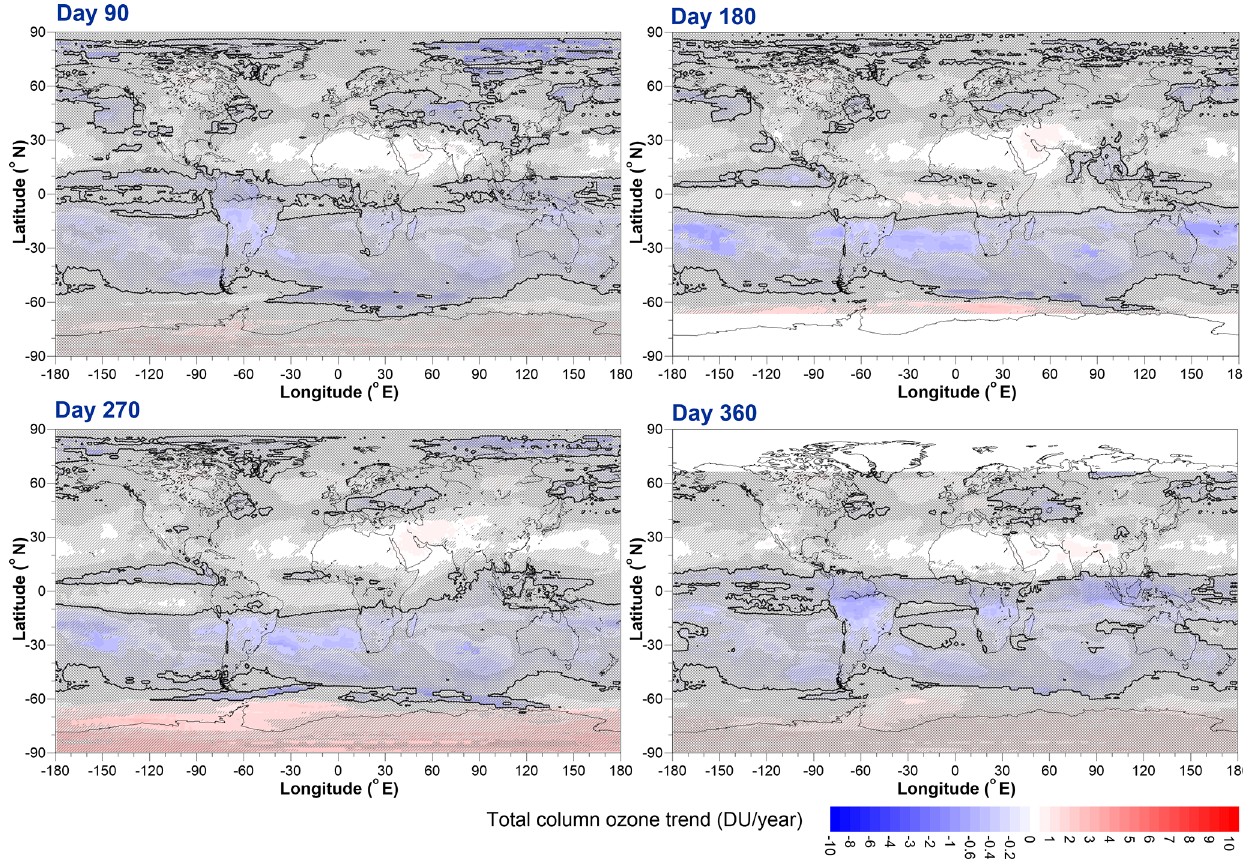
Figure 18. Inferred trends in TCO after 2000 evaluated at (a) day 90, (b) day 180, (c) day 270, and (d) day 360, obtained by adding the B and C regression model fit coefficients. The solid black line shows zero trend. The same hatching regimen as used in Fig. 16 is used here.